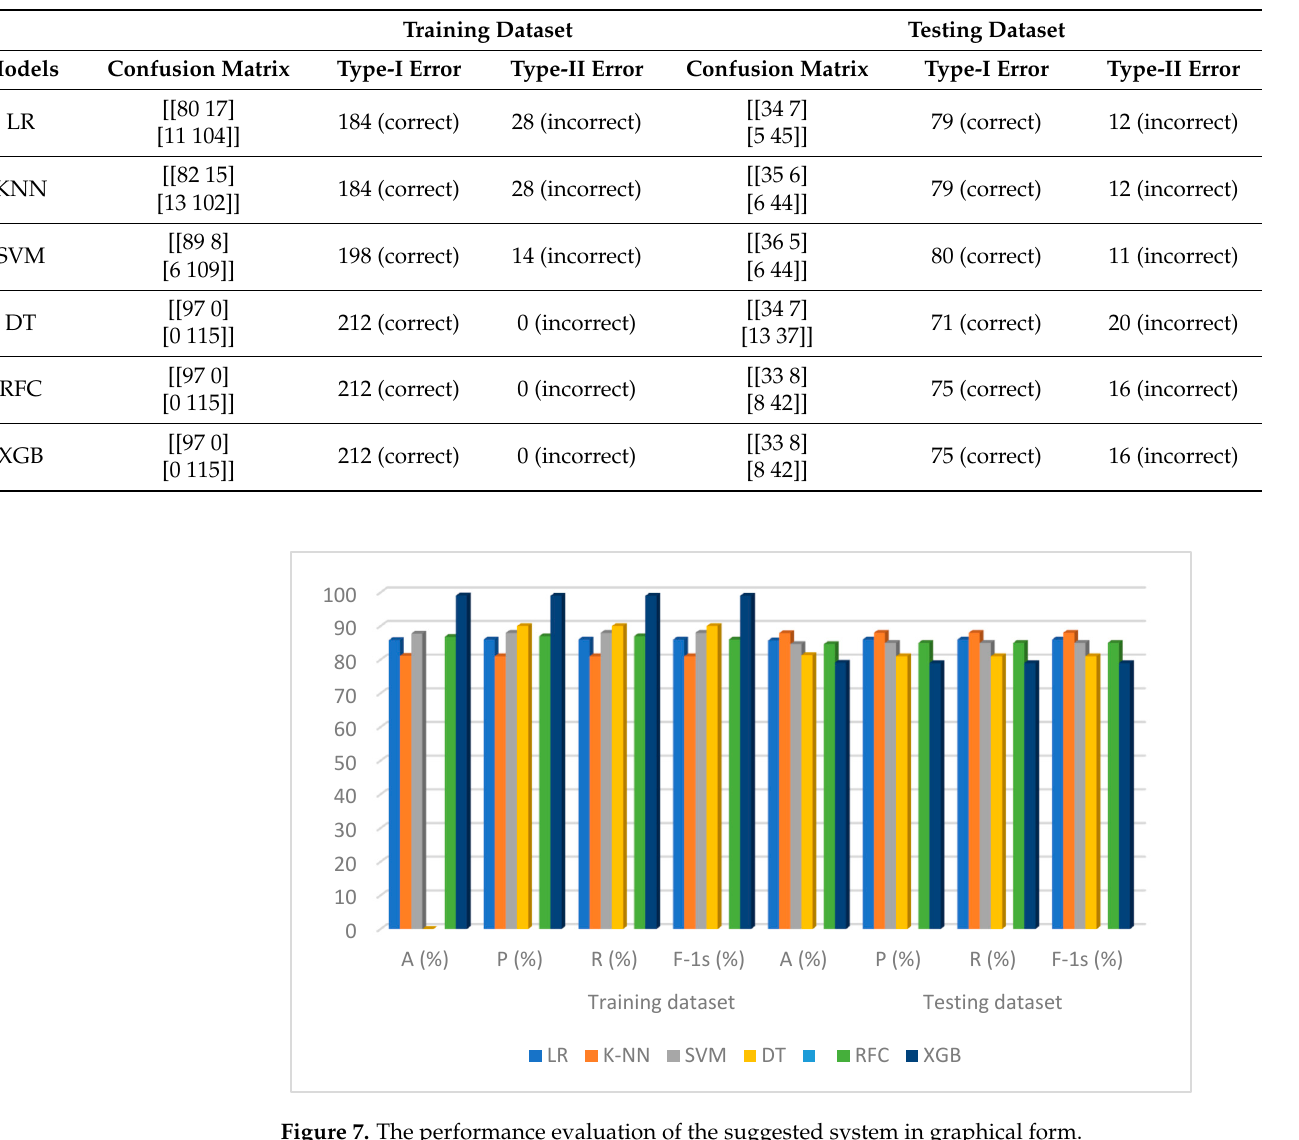
Table 5. Performance evaluation using a confusion matrix on the training and testing datasets.